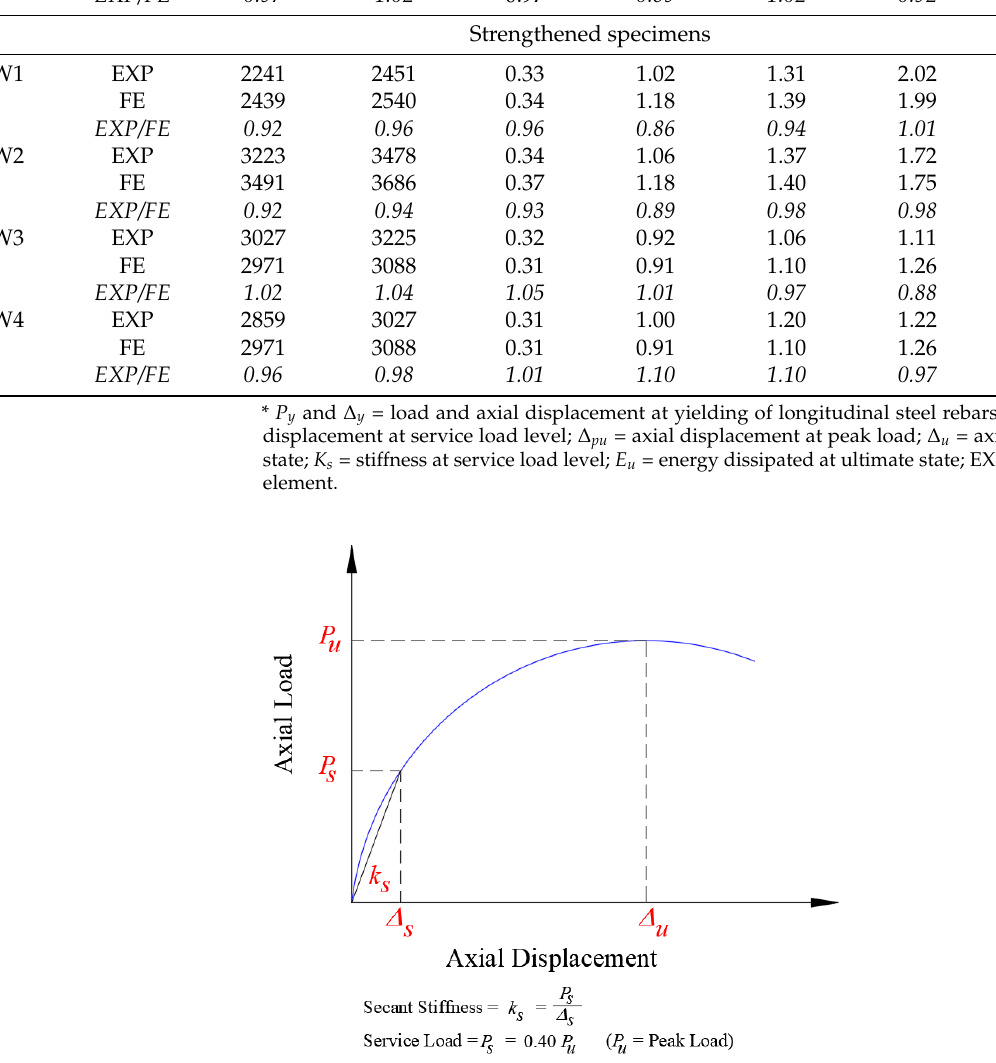
Figure 9. Calculation of secant stiffness for tested columns [7,50,51].